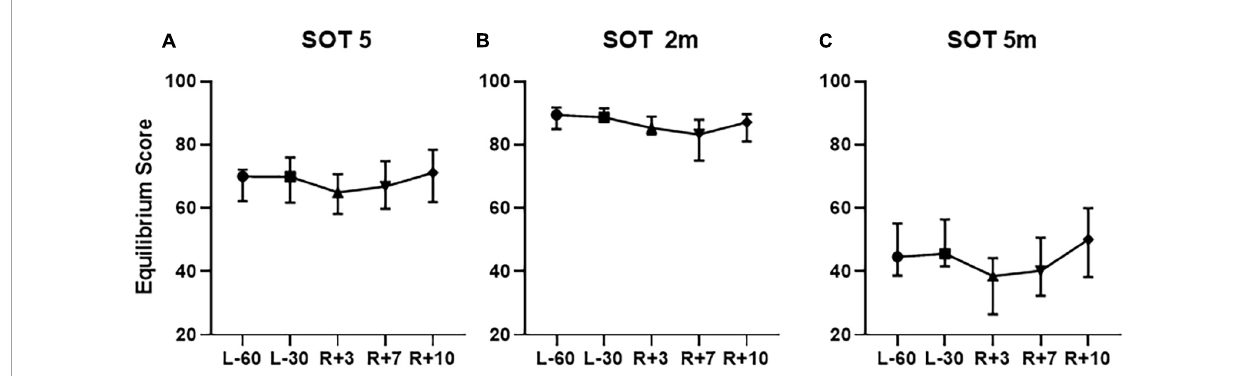
FIGURE14 Median Equilibrium Score in (A) SOT5, (B) SOT2m, (C) SOT5m tests. L-60 – 60 days before launch, L-30 – 30 days before launch, R + 3 – 3rd day of recovery period after landing, R + 7 – 7th day after landing, R + 10 – 10th day after landing.